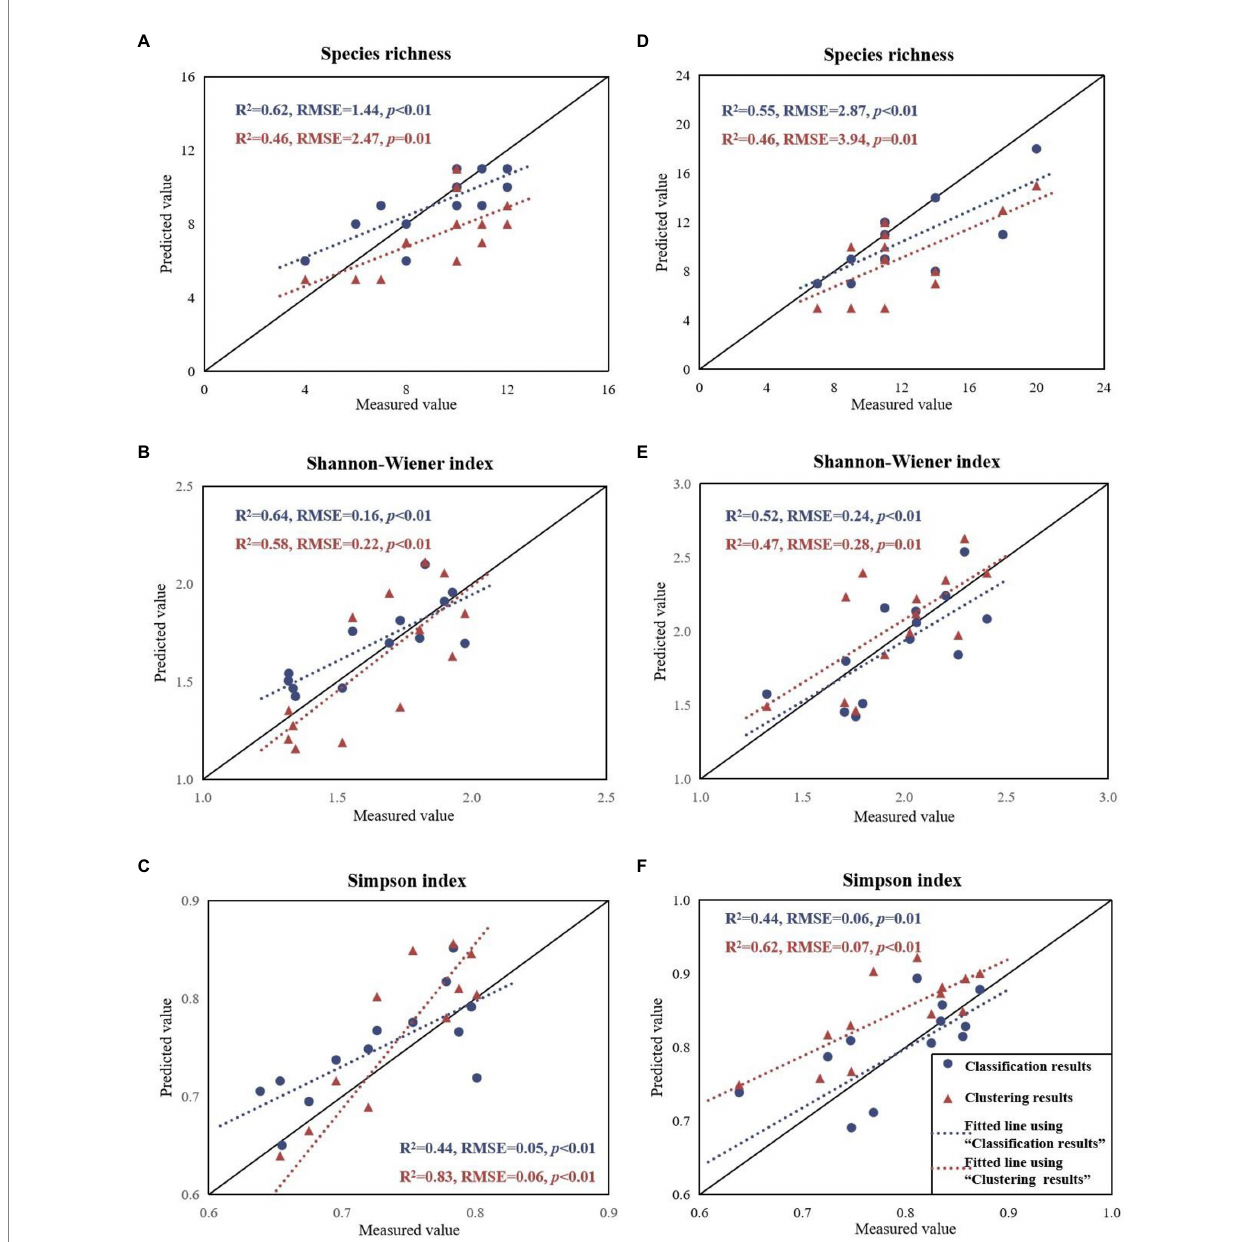
FIGURE 5 Field-measured species diversity indices compared with the predicted values based on classification and clustering approaches for MZL (left) and GGS (right).